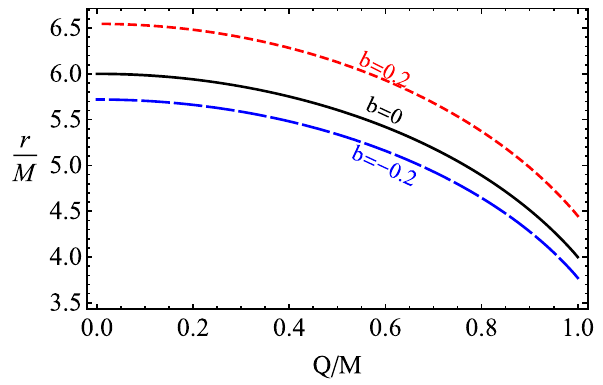
Fig. 3 DependenceoftheISCOradiusofamagnetizedparticlearound magnetically charged RN black holes from the magnetic charge (top panel) and the parameter β (bottom)